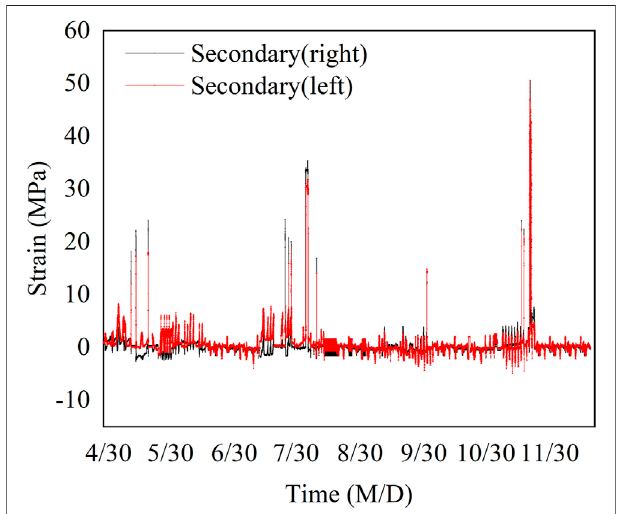
FIGURE 10 | The stress course of rods during the long-term monitoring